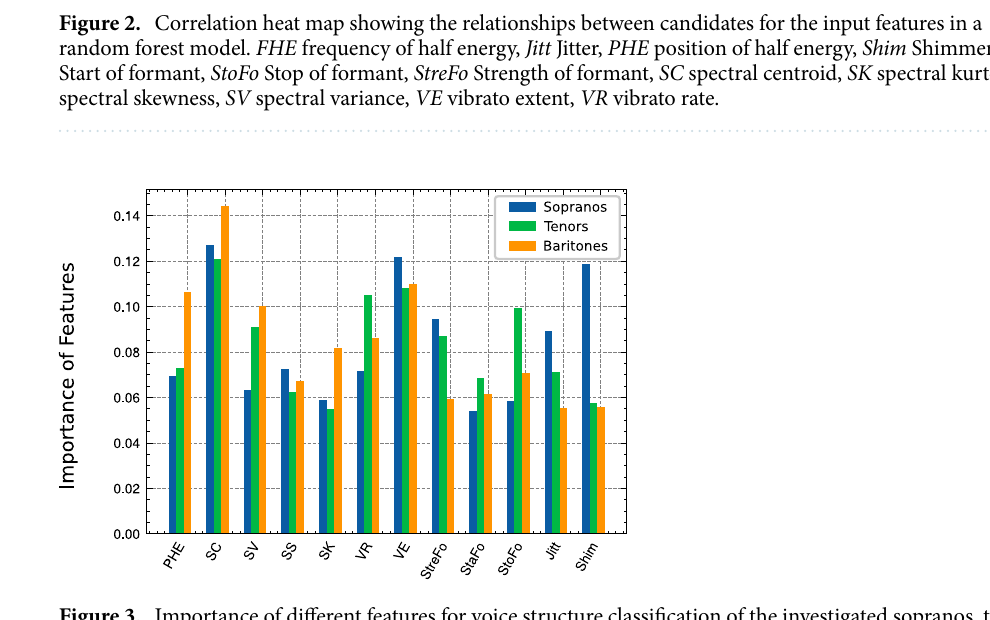
Figure 3. Importance of different features for voice structure classification of the investigated sopranos, tenors, and baritones (balanced error rates: 18.0%, 19.6%, and 17.5% respectively), based on information